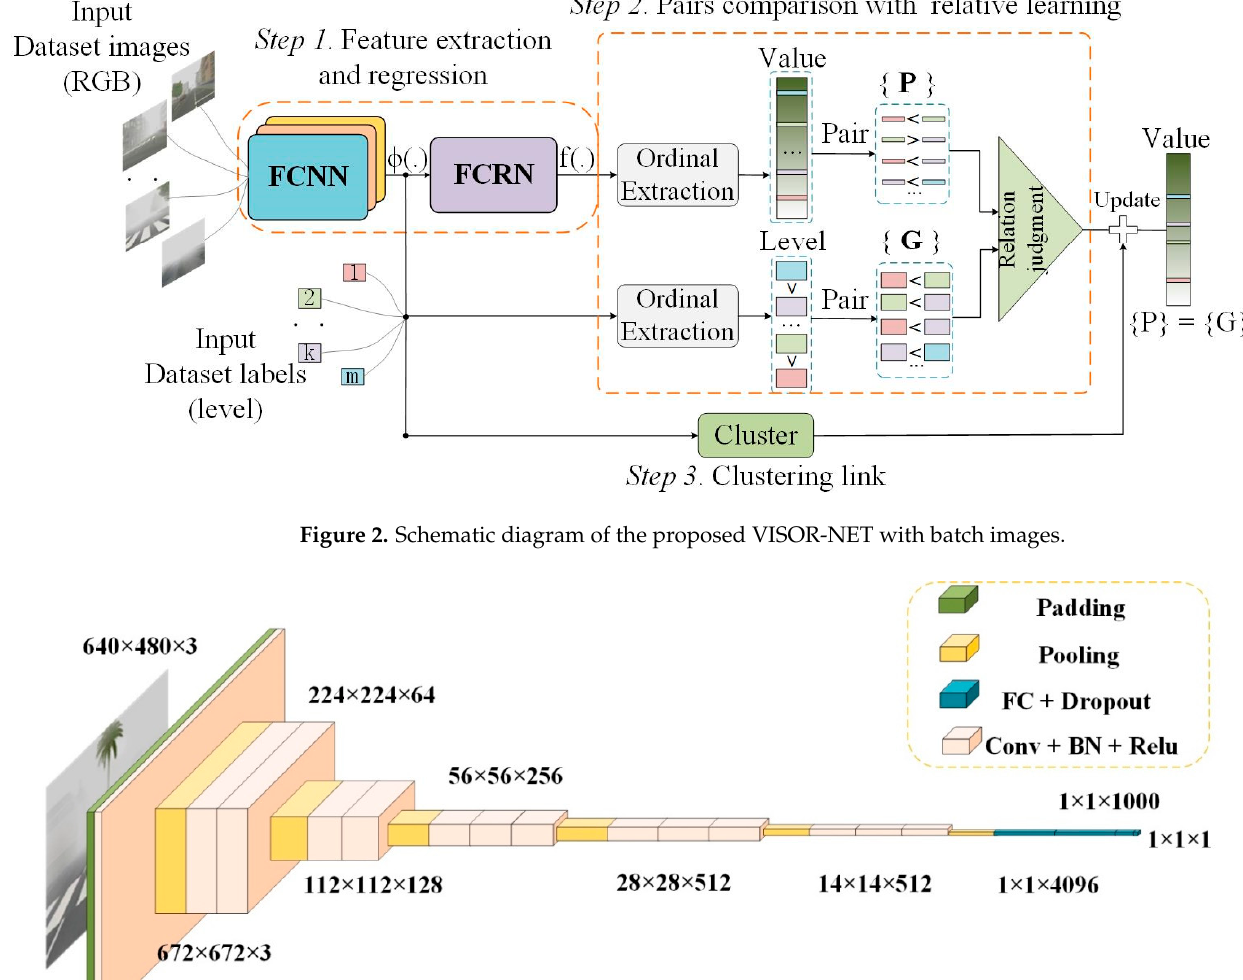
Figure 3. Structural diagram of the feature extraction and regression module (FERM).